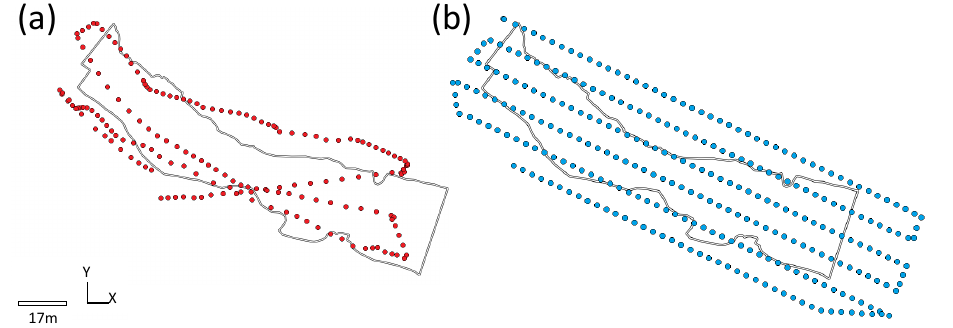
Figure 10. Image locations for flights ( a ) V_S2_2019 (manual flight) and ( b ) V_S2 (planned flight). Please note the more regular image distribution that characterizes the planned